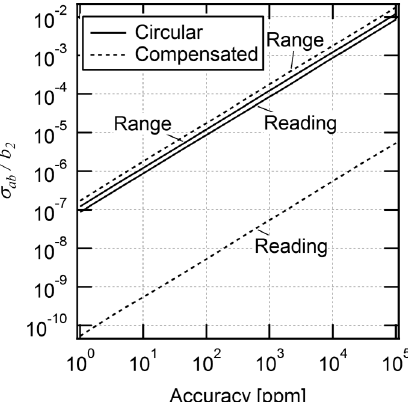
FIG. 10. Estimated sensitivity to the accuracy of the voltmeter. For this simulation, the value of the normal quadrupole signal was equal to the range. For each point, the standard deviation was obtained from 100